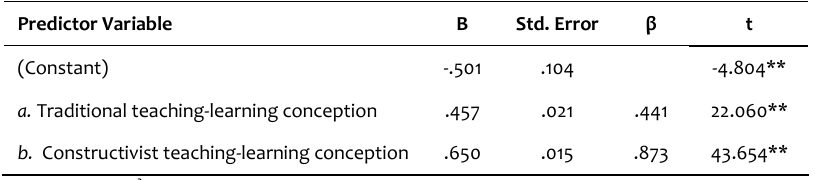
Table 6: Prediction Level of Teachers’ Learning-Learning